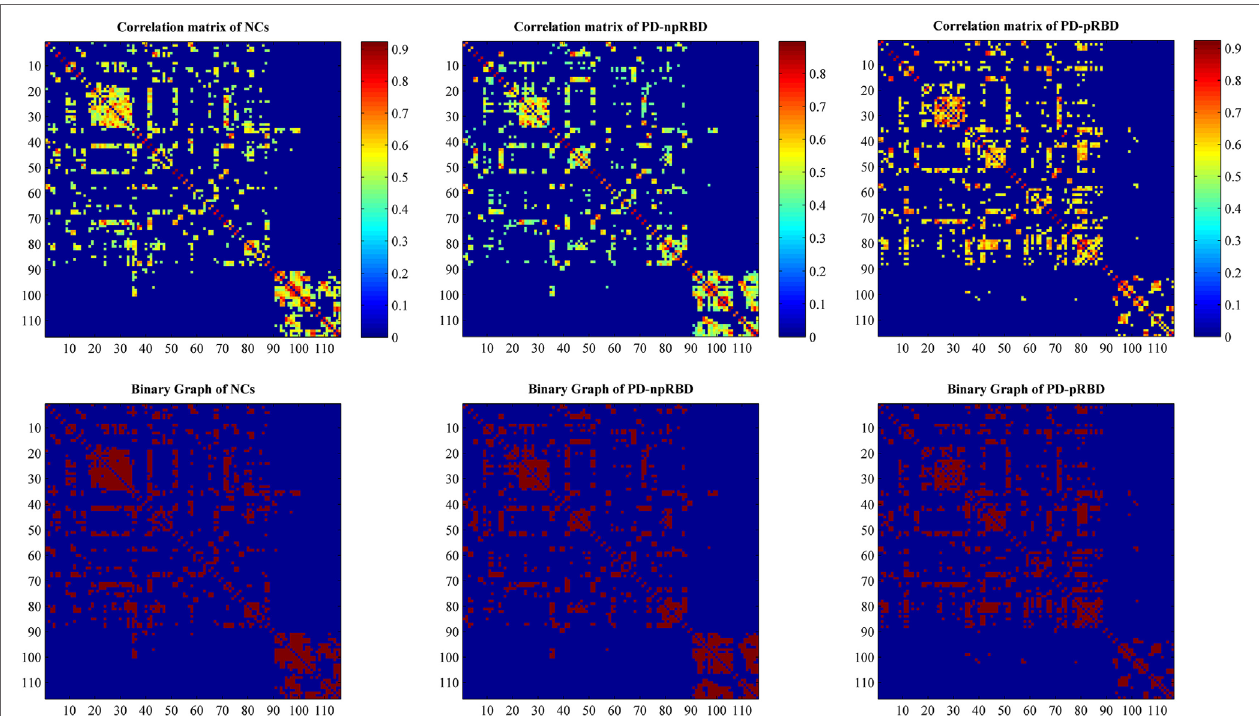
FigUre 1 | Structural correlation matrices for normal controls (NCs), Parkinson’s disease (PD) patients with possible rapid eye movement sleep behavior disorder (RBD) (PD-pRBD), and PD patients with non-possible RBD (PD-npRBD). The upper row represents weighted structural correlation matrices for NCs, PD-npRBD, and PD-pRBD; the color bar shows the strength of the connections. The lower row represents corresponding binary correlation matrices for NCs, PD-npRBD, and PD-pRBD; red color shows the presence of